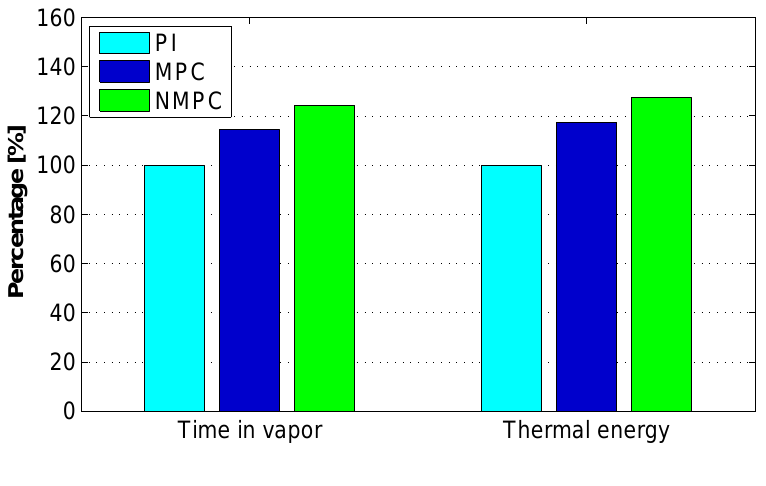
Figure 11. Time in the vapor state and recovered thermal energy for the MPC and NMPC strategy compared to the PI control